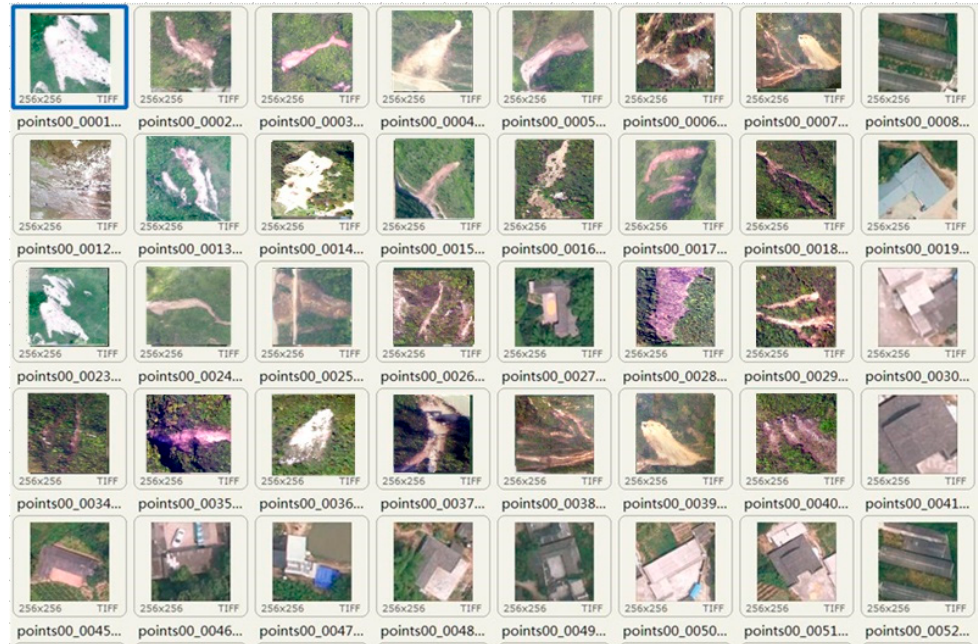
Figure 11. Partial of sample examples clipped and stored.